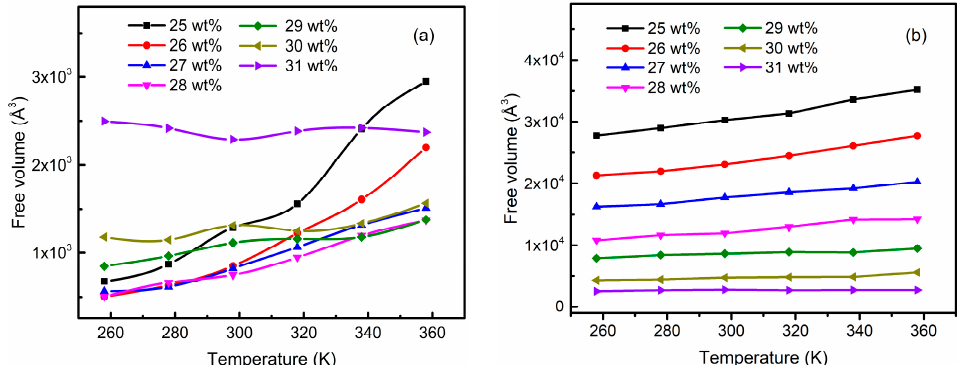
Figure 10. Free volume of aluminum sols with different solid contents: ( a ) with solvents; ( b ) without solvents.